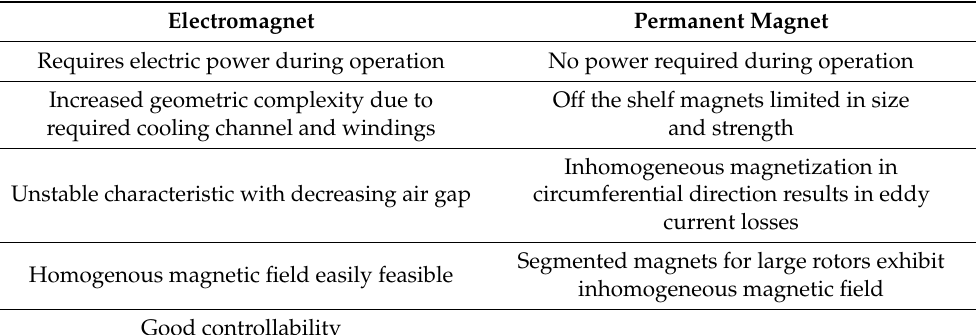
Table 3. Comparison of electromagnetic and permanent magnetic weight compensation setup.